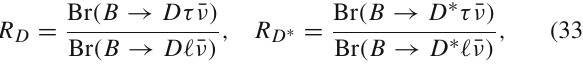
Fig. 2 Contour plot of the fit to R K and R K ∗ in the plane of Wilson coefficientsatthescale μ = 1TeV.Upperleftpanelcorrespondsto C μμ versus C as real. The dashed orange and dotted blue contours repre- 10 sent the 1 σ allowed regions that explain R K and R K ∗ respectively. The dark green (yellow) region corresponds to the 1 σ allowed region that explains R K and R K ∗ ( R and R K ∗+ ) simultaneously, while lighter K 0 S region corresponds to 2 σ allowed region. Upper right: The plot corre-